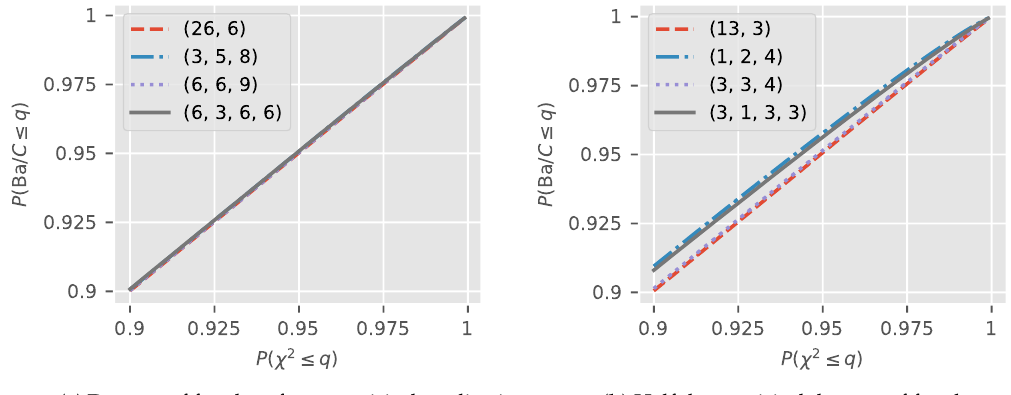
Figure 5. pp-plots for the adjusted Bartlett distribution Ba/ C against χ 2 for varying degrees of freedom. ( a ) and ( b ) show results for degrees of freedom corresponding to the empirical applications and half those degrees of freedom, respectively.